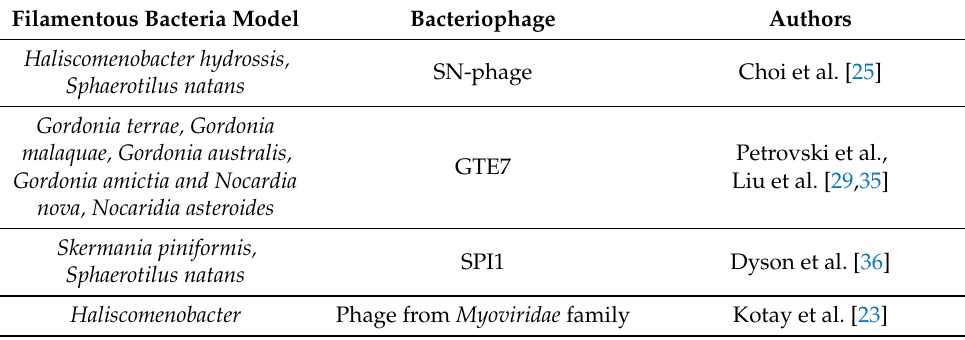
Table 1. Bacteriophages capable of lysing filamentous bacteria